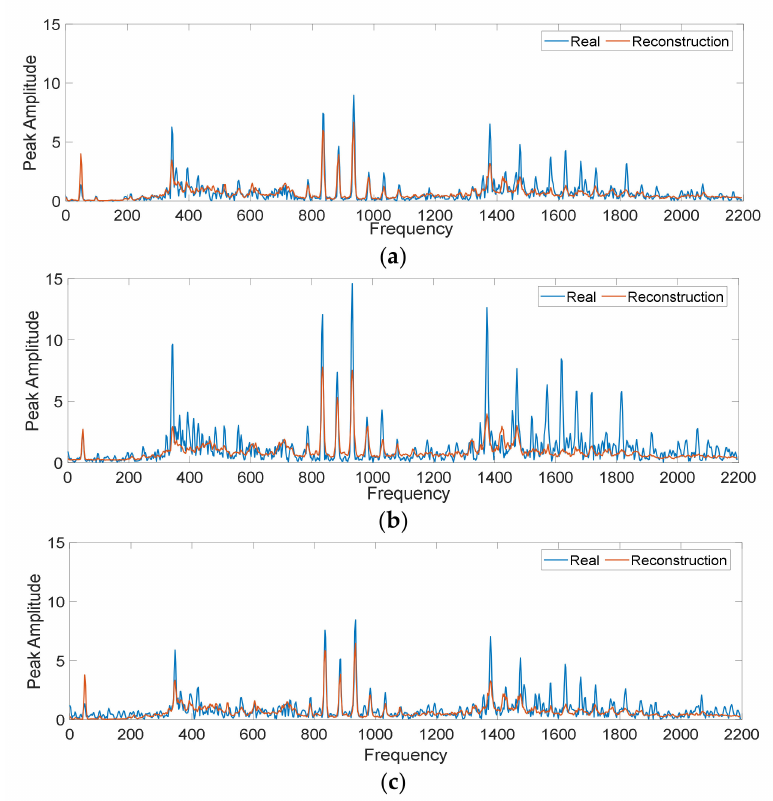
Figure 10. Characterization of vibration signals in F-D on operating conditions Ps2 and Lc2 for: ( a ) healthy condition, ( b ) healthy condition with root mean square (RMS) added ( c ) healthy condition with white Gaussian noise